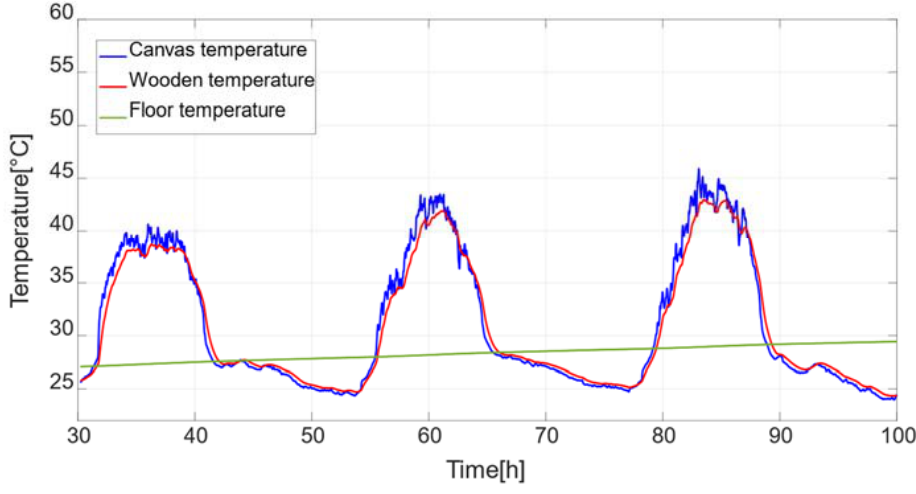
Figure 5. Simulation of canvas temperature, wooden structure, and floor temperature versus time.